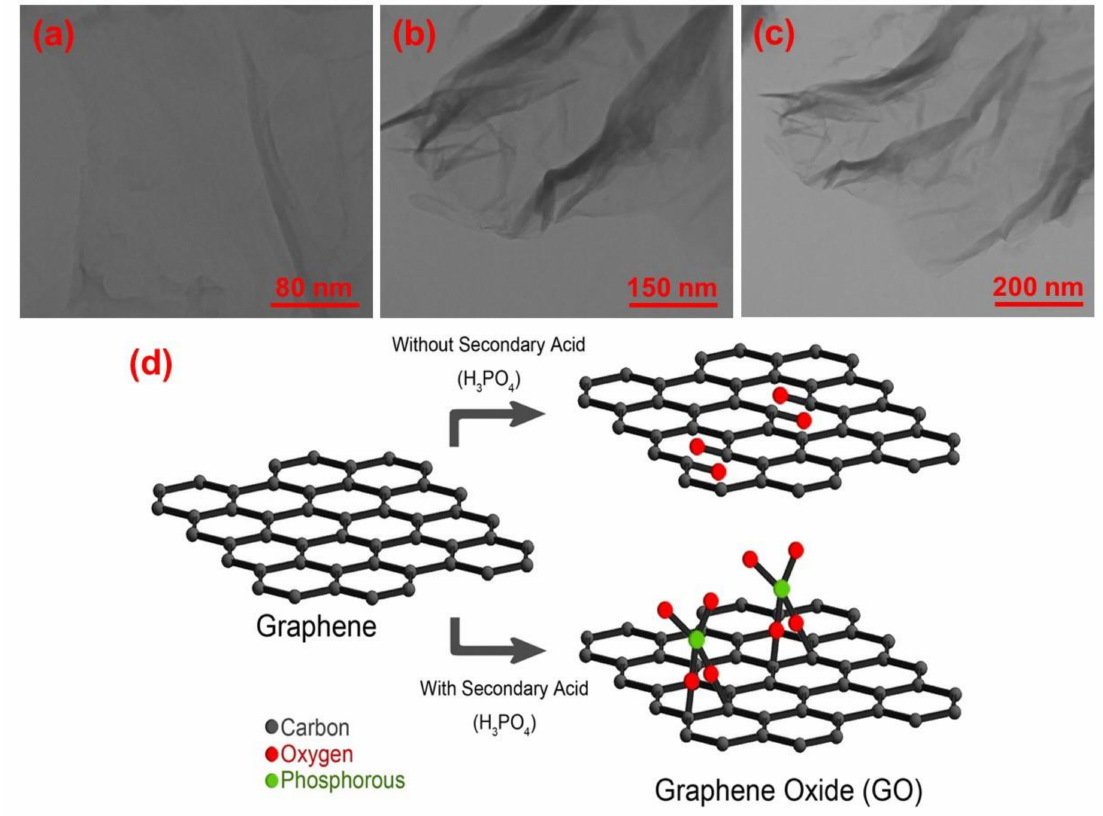
Figure 2. ( a – c ) A view of GO’s TEM images at diverse scales (i.e., 80, 150, and 200 nm) and ( d ) performance of secondary acid (H 3 PO 4 ) in minimizing the overall amount of defects throughout the graphitic carbonaceous